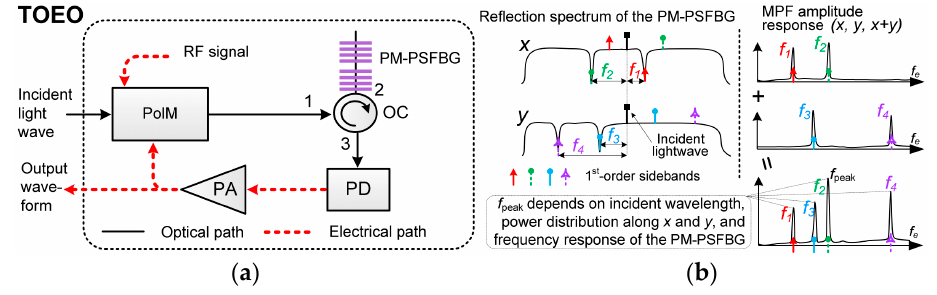
Figure 3. ( a ) Schematic diagram of an OEO-based frequency-hopping signal-generation scheme. PoIM: polarization modulator; OC: optical coupler; PD: photodetector; PA: electrical power amplifier. ( b ) Operation principle of the OEO (with the courtesy of Dr J. Yao).